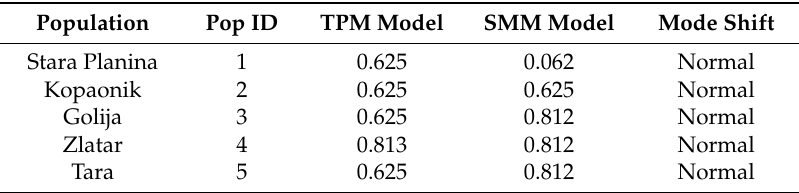
Table 7. Wilcoxon signed-rank tests for heterozygosity excess and mode shift under two-phase mutation model (TPM) and stepwise mutation model (SMM). Statistically significant deviation from equilibrium is present if the value is less than 0.05.